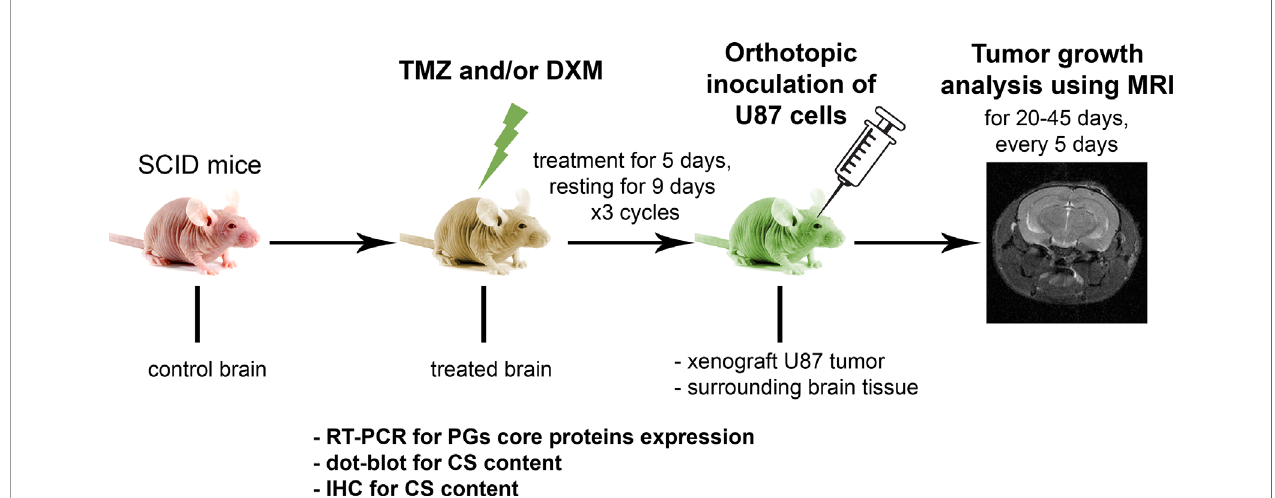
FIGURE 2 | Experimental GBM relapse animal model. Scheme of the experiment to study the effects of pre-treatment of SCID mice with chemotherapeutic drugs on the growth of xenograft U87 tumors. PG, proteoglycan; CS, chondroitin sulfate; TMZ, temozolomide; DXM,